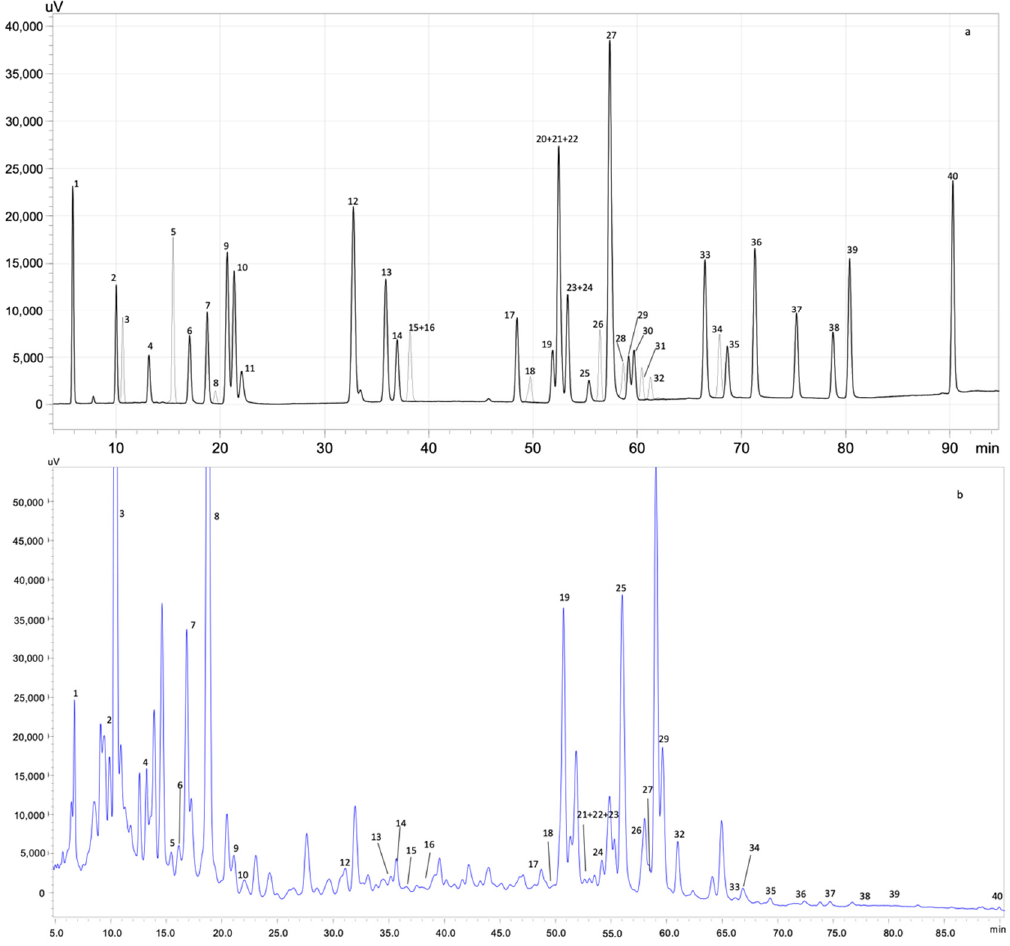
Figure 2. HPLC-PDA chromatogram monitored at 280 nm for ( a ) polyphenol standard mixture of 5 mg/L and ( b ) optimal extract from kiwiberry leaves; peak identification: (1) gallic acid, (2) protocate- chuic acid, (3) neochlorogenic acid, (4) (+)-catechin, (5) caftaric acid, (6) caffeine, (7) chlorogenic acid, (8) 4- O -ca ff eyolquinic acid, (9) vanillic acid, (10) ca ff eic acid, (11) syringic acid, (12) ( − )-epicatechin, (13) p -coumaric acid, (14) ferulic acid, (15) sinapic acid, (16) trans-polydatin, (17) naringin, (18) 3,5- di-caffeoylquinic acid, (19) quercetin-3- O -galactoside, (20) resveratrol, (21) quercetin-3- O -glucopy- ranoside, (22) rutin, (23) phloridzin, (24) ellagic acid, (25) 3,4-di- O -caffeoylquinic acid, (26) myrice- tin, (27) cinnamic acid, (28) quercitrin, (29) kaempferol-3- O -glucoside, (30) isorhamnetin-3- O -gluco- side, (31) kaempferol-3- O -rutinoside, (32) isorhamnetin-3- O -rutinoside, (33) naringenin, (34) trans- epsilon viniferin, (35) quercetin, (36) phloretin, (37) tiliroside, (38) kaempferol, (39) apigenin and (40) chrysin.